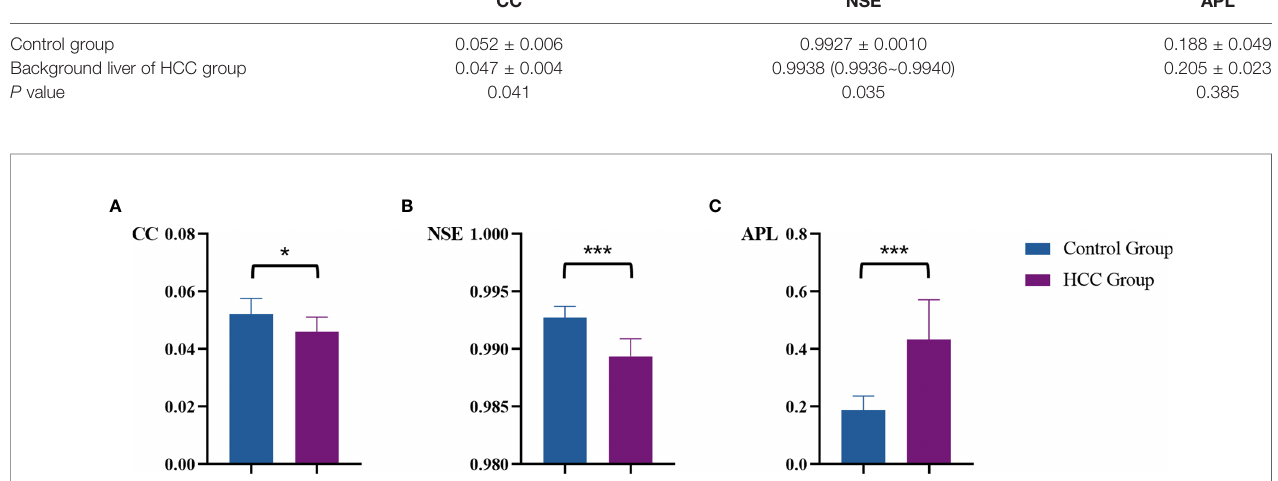
FIGURE 4 | Comparison of vascular parameters (A) CC, (B) NSE and (C) APL of the control group and the tumor region of HCC group. * p < .05, *** p < .001.